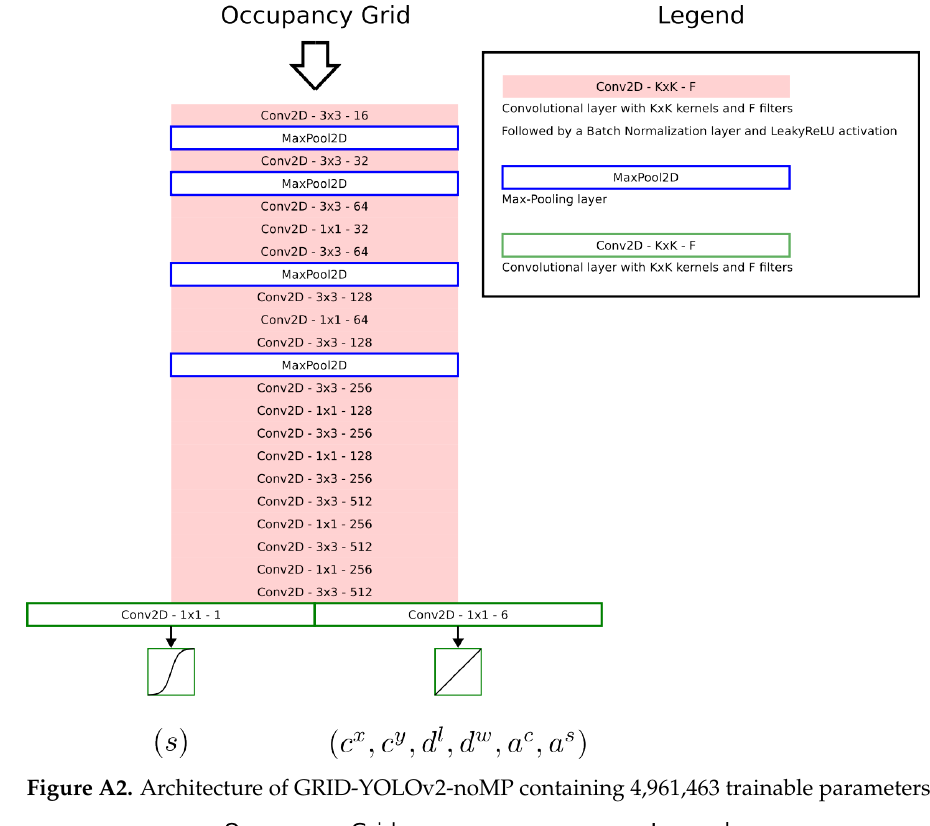
Figure A2. Architecture of GRID-YOLOv2-noMP containing 4,961,463 trainable parameters.